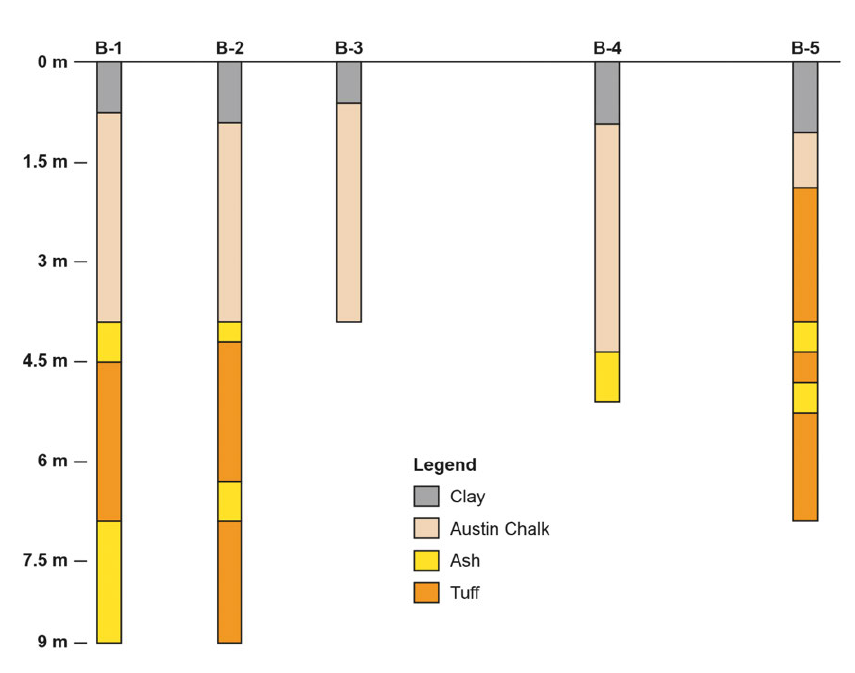
Figure 16: Correlation of data from five boreholes. Note that all boreholes are shown aligned; however, boreholes B-4 and B-5 are actually located to the southeast of boreholes B-1, B-2 and B-3 (see Figure